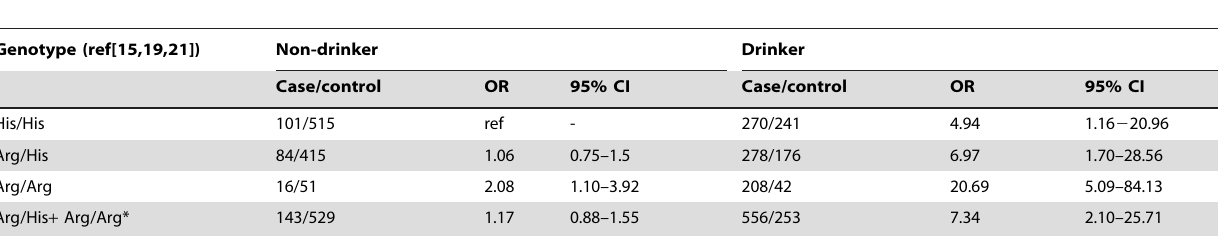
Table 2. Interaction between alcohol drinking and ADH1B genotypes on